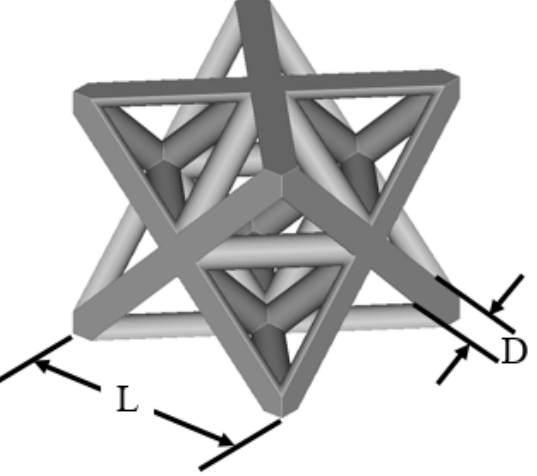
Figure 6. Octet truss unit cell with length (L) and strut diameter (D) lattice dimensions.